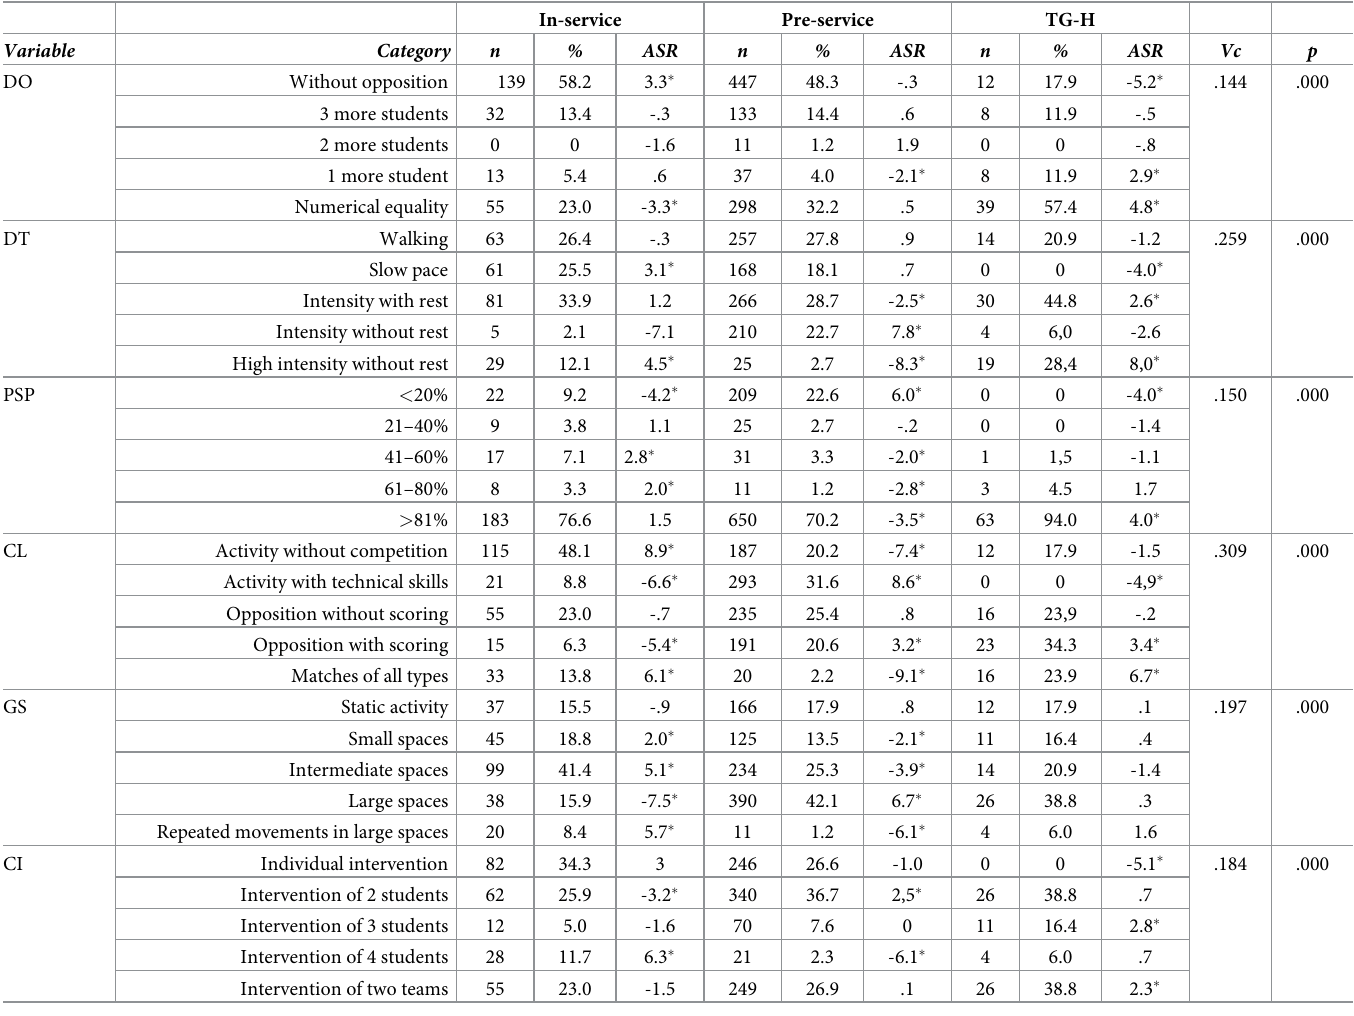
Table 2. Descriptive analysis of eTL